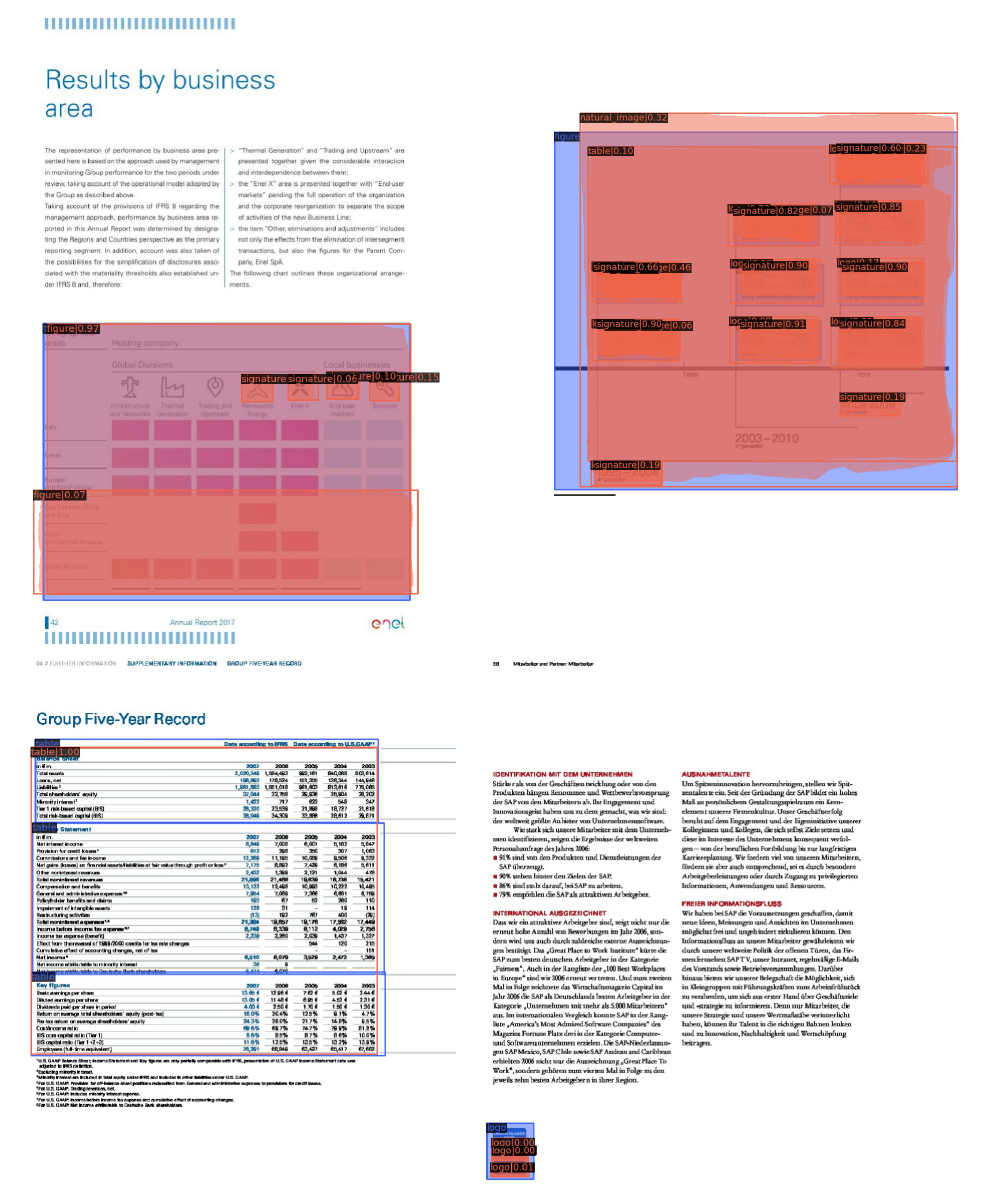
Figure 9. Visualizing some detection results for the models in Table 7. First row: The two images show the detection results for Dual-Backbone Swin Transformer Tiny Mask R-CNN. Second row: The first image shows the detection results for Dual-Backbone Faster R-CNN, and the second shows the detection results for Dual-Backbone Swin-Transformer Small Cascade Mask